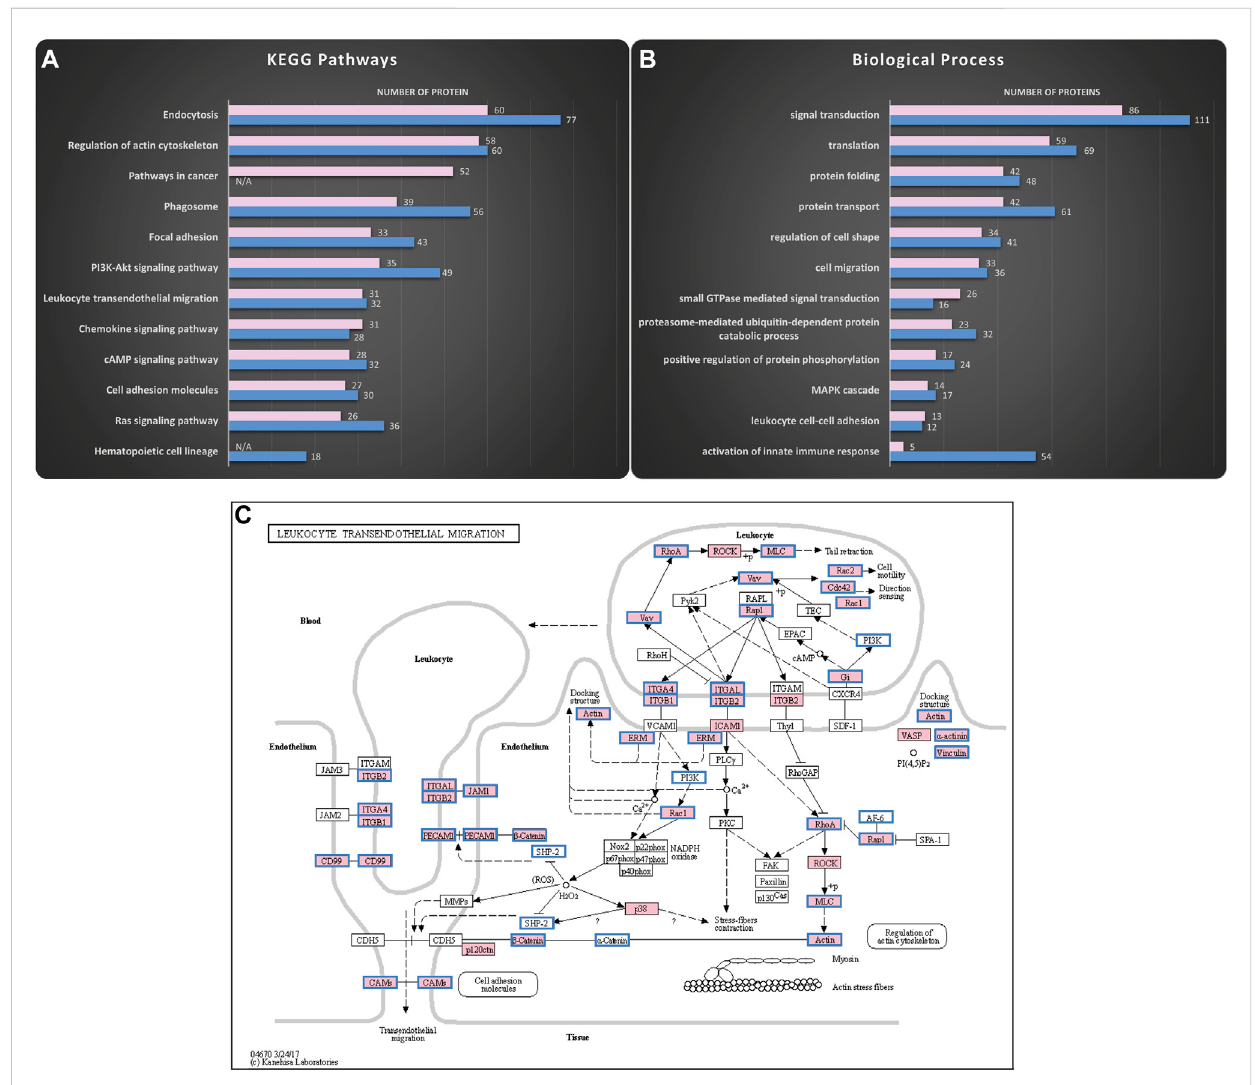
FIGURE 1 Mass spectrometry analysis reveals HSPCs-derived exosomes are enriched in proteins involved in adhesion and migration. Proteomics analysis of thecargowasperformedtouncoverputativefunctionsoftheisolatedexosomes.TheKEGGpathwaysandtheBiologicalProcessesfromGeneOntology analysis that wereenriched intheKG1a (pink)and healthyHSPCs (blue)-derived exosomes wereidenti fi edusingtheDAVID online tool. (A) Tophitsofthe KEGG pathways identi fi ed included pathways related to vehicle-traf fi cking and adhesion-migration functions. Furthermore, there was enrichment in signaling networks, highly related to the regulation of migration. The complete list of the identi fi ed KEGG pathways can be found in “ HSPCs-derived exosomes proteome analysis. ” Datasheet 2. (B) Top hits of Biological Processes identi fi ed included processes related to cell adhesion and signaling cascades, con fi rming the KEGG pathways. The complete list of identi fi ed Biological Processes can be found in “ HSPCs-derive exosomes proteome analysis. ” Datasheet 2. (C) KEGG map revealed proteins in KG1a (pink) and healthy HSPCs (blue frame)-derived exosomes related to Leukocyte TransendothelialMigration.Amongtheidenti fi edproteins,therewereintegrins(e.g.,integrin-alpha),cytoskeleton-relatedproteins(e.g.,actin,ezrin),and chemokines (e.g.,